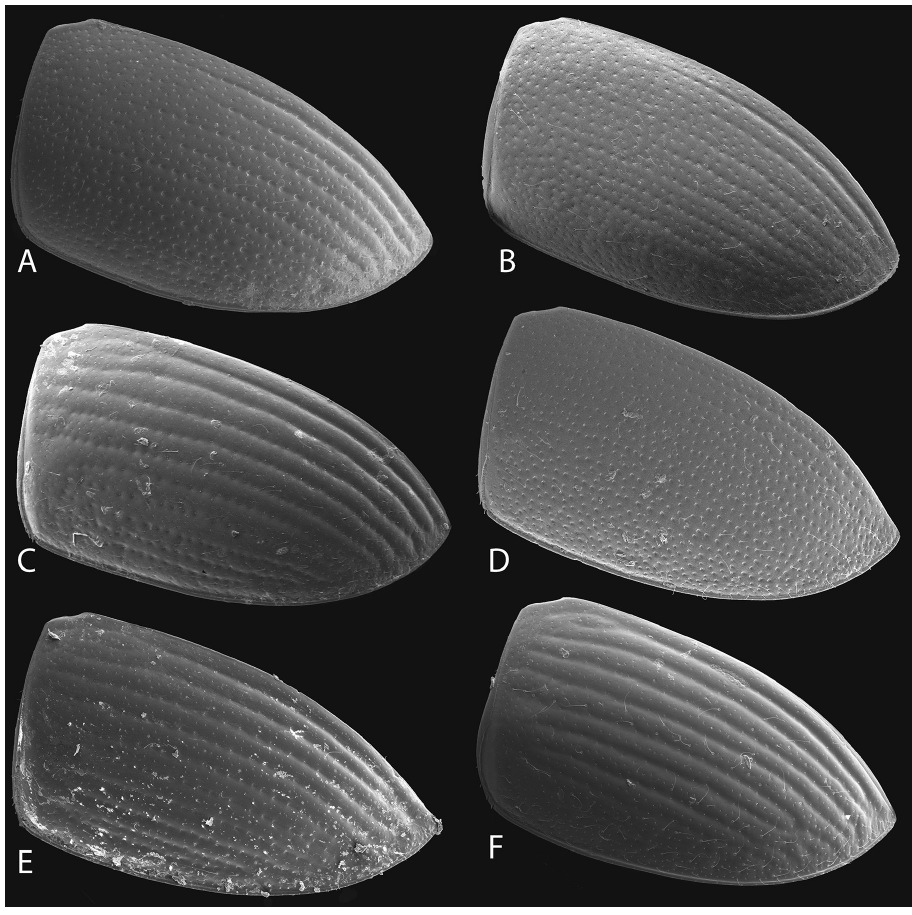
Figure 11. Elytra of Tobochares spp. A T. sipaliwini B T. kasikasima C T. striatus D T. pallidus sp. n. E T. canaliculatus sp. n. F T. sulcatus